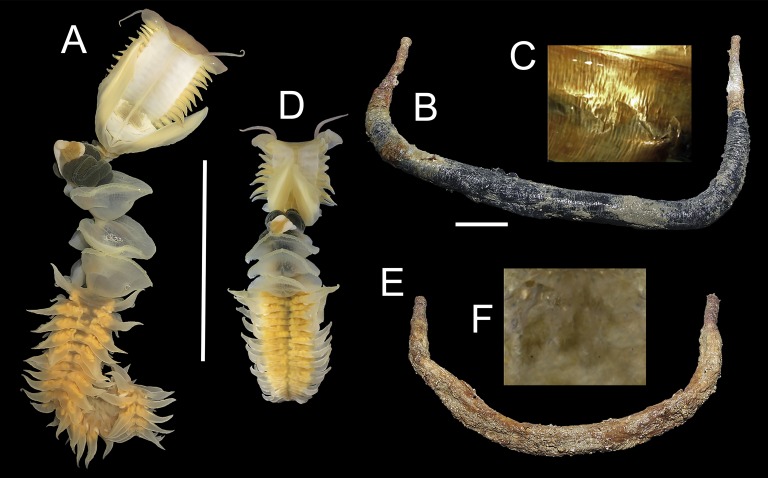
Chaetopterus cf. appendiculatus: (A) whole worm; (B) tube; (C) detail of inner tube surface. Chaetopterus sp.: (D) whole worm; (E) tube; (F) detail of inner tube surface.Scale bars are 5 cm.